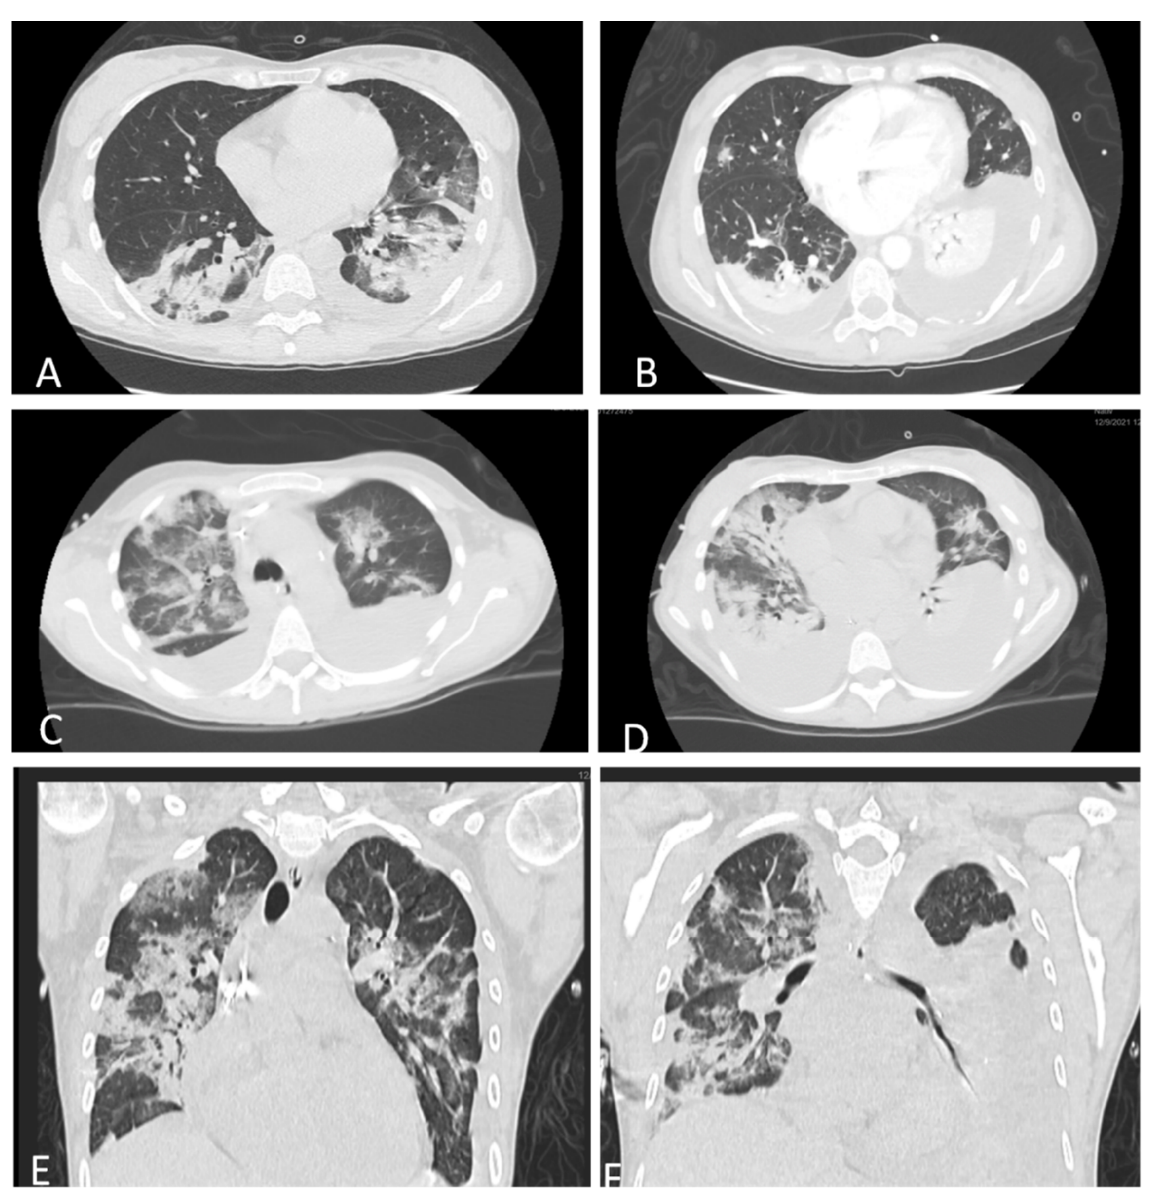
Figure 2. Thoracic CT scan. ( A ) Native thoracic scan showing bilateral COVID-19 pneumonia, affecting 30% of the lungs, and minimal right pleural effusion. ( B ) Contrast-enhanced thoracic CT scan revealing medium right pleural effusion and bilateral COVID-19 pneumonia. ( C , D ) Native thoracic CT scan, transversal view with bilateral pleural effusions and bacterial pneumonia. ( E , F ) Native thoracic CT scan, sagittal view with large right pleural effusion, inferior right lobe atelectasis, and bacterial pneumonia.